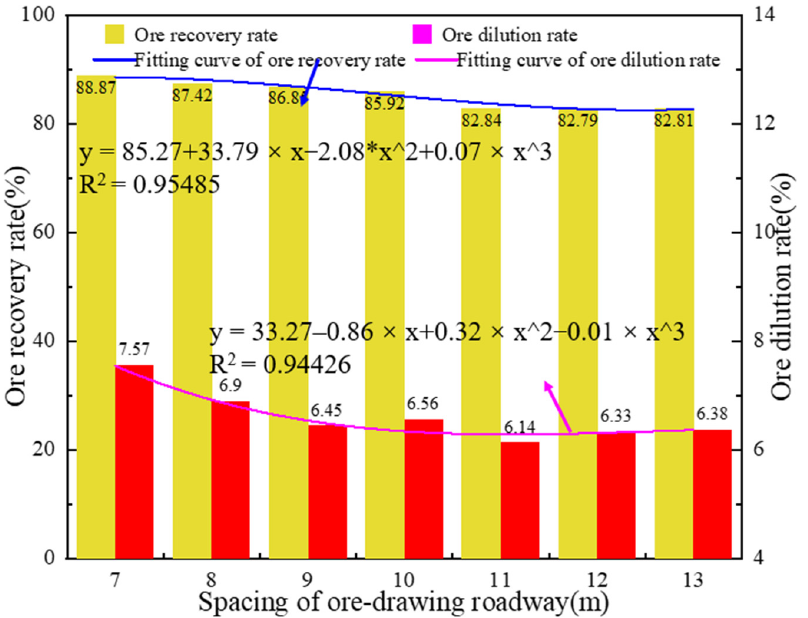
Figure 15. Influence of different spacing of extracted ore drift on recovery ratio and dilution ratio.